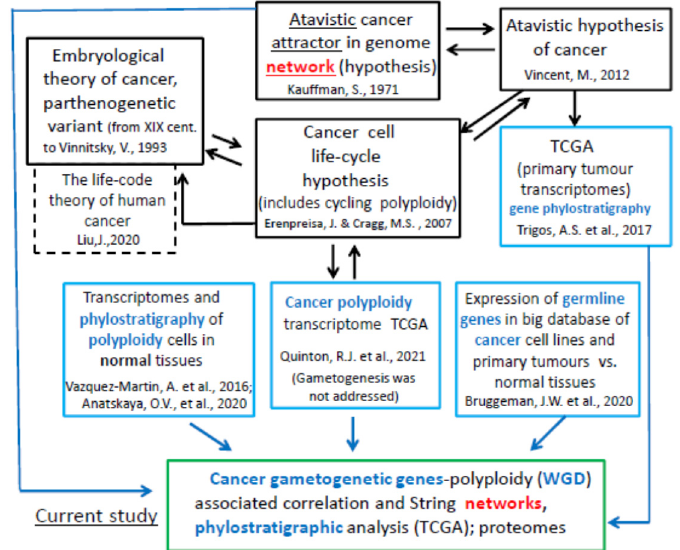
Figure 1. The context, aims, and design of the current bioinformatics study: in black boxes, the theoretical prerequisites; in blue boxes, what has been performed in previous similar studies (see the citations in the reference list [14,25,38,41,60,65,69,72,74,86]); in a green box, the aims and design addressed in the current study.